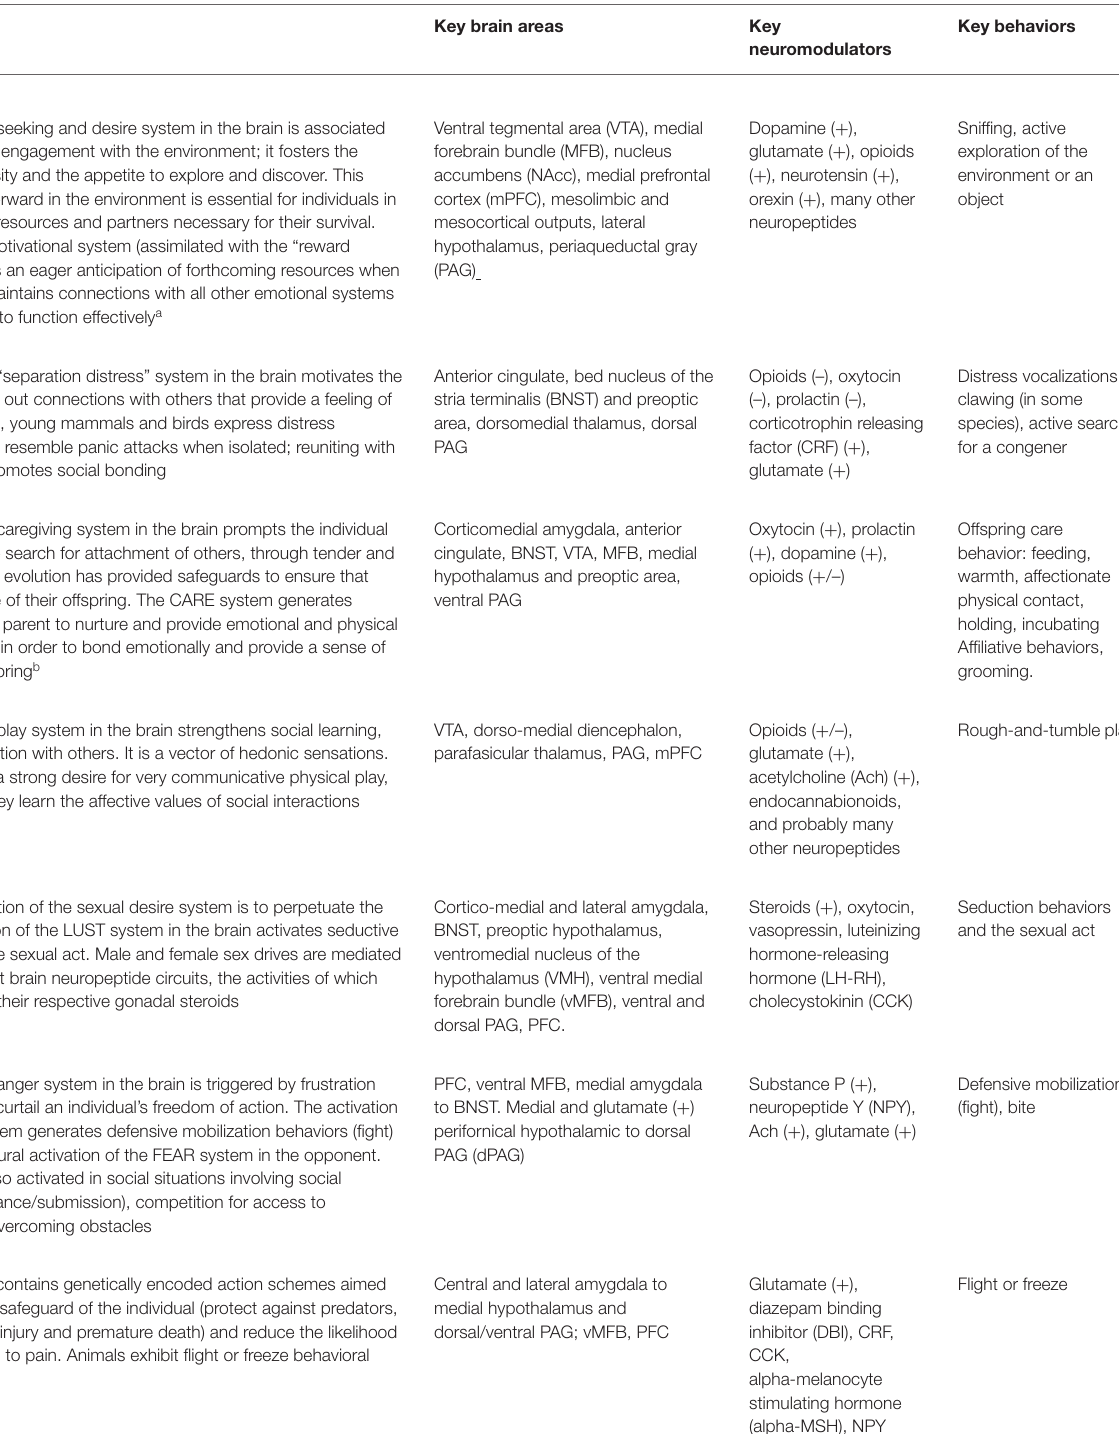
TABLE 1 | Description of the seven primary emotional systems identified by Panksepp (71).